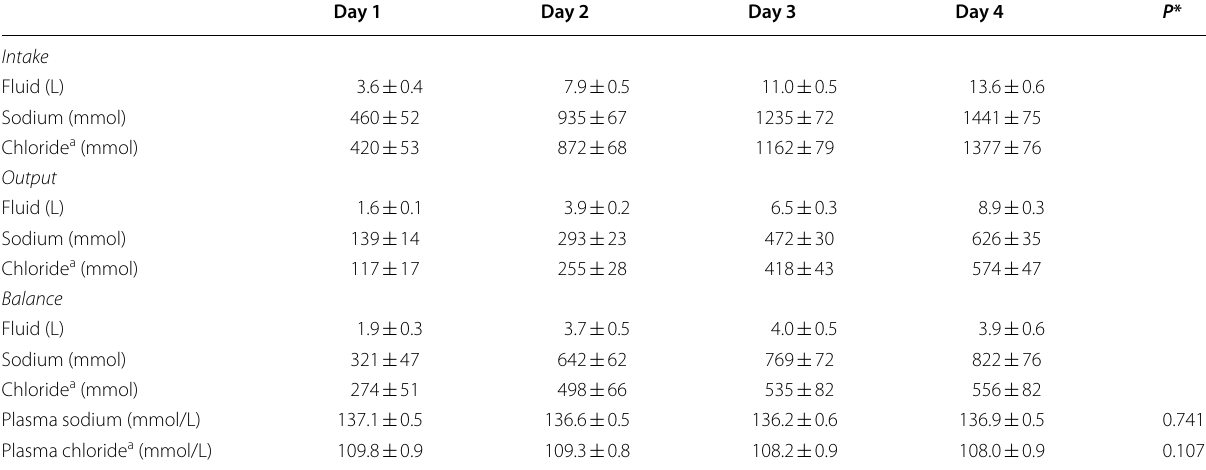
Data are depicted as mean SE ± * Difference between day 1 and day 4 a Chloride data were available for 27, 27, 24 and 28 patients, respectively, on day 1 to day 4